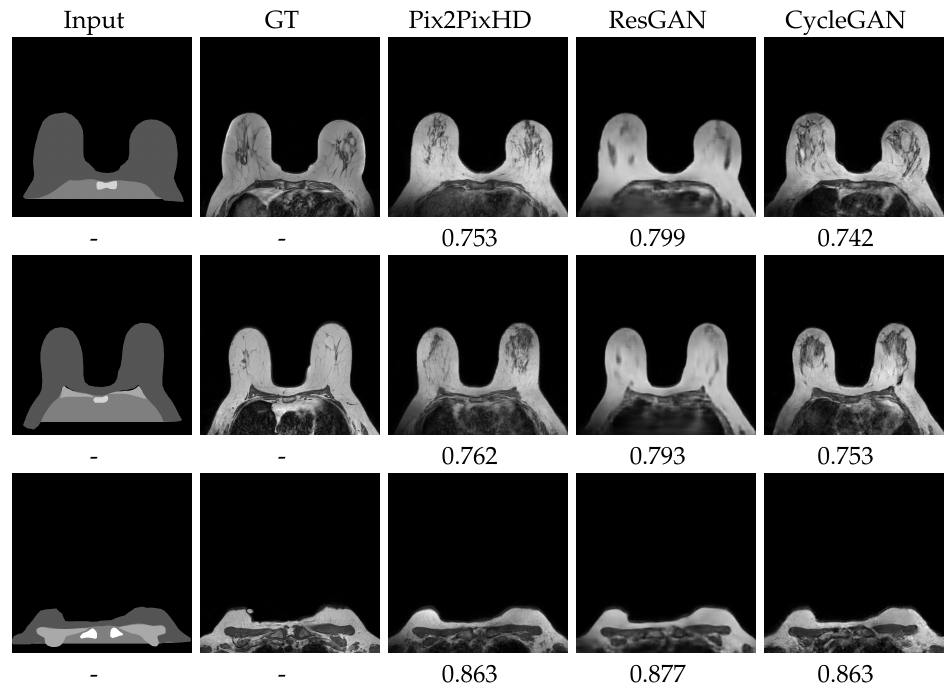
Figure 6. Best visual test set generation results and respective SSIM. ResGAN and Pix2PixHD with BS8. CycleGAN with BS1 and Experience Replay. More results on Appendix A Figures A1 and